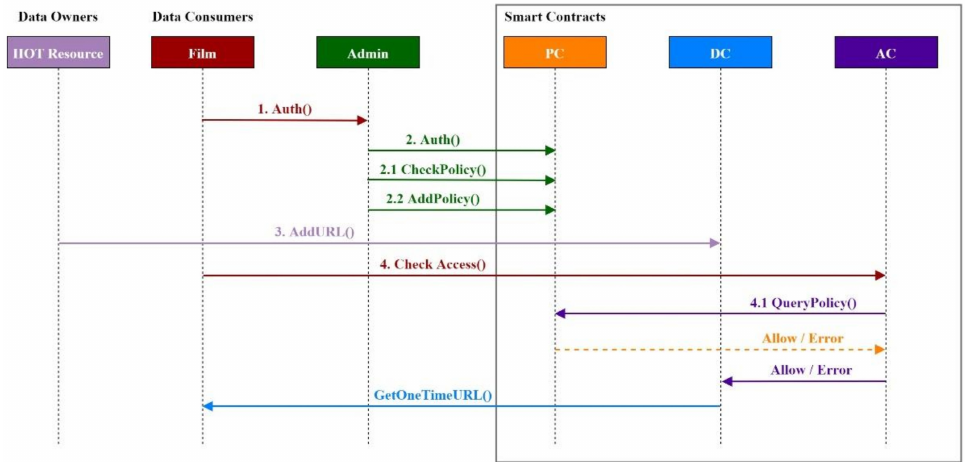
Figure 10. Access control sequence diagram.